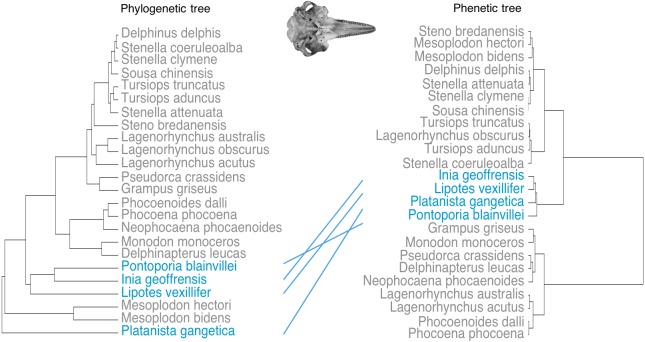
Tanglegram showing comparison in the position of the river dolphins on a phylogenetic tree and a phenetic tree based on cranial morphology.Lines between trees link the same species and crossing lines indicate a lack of similarity in the two trees (e.g., where phenotype is more similar than implied by phylogeny, indicative of convergence). River dolphins are highlighted in blue.